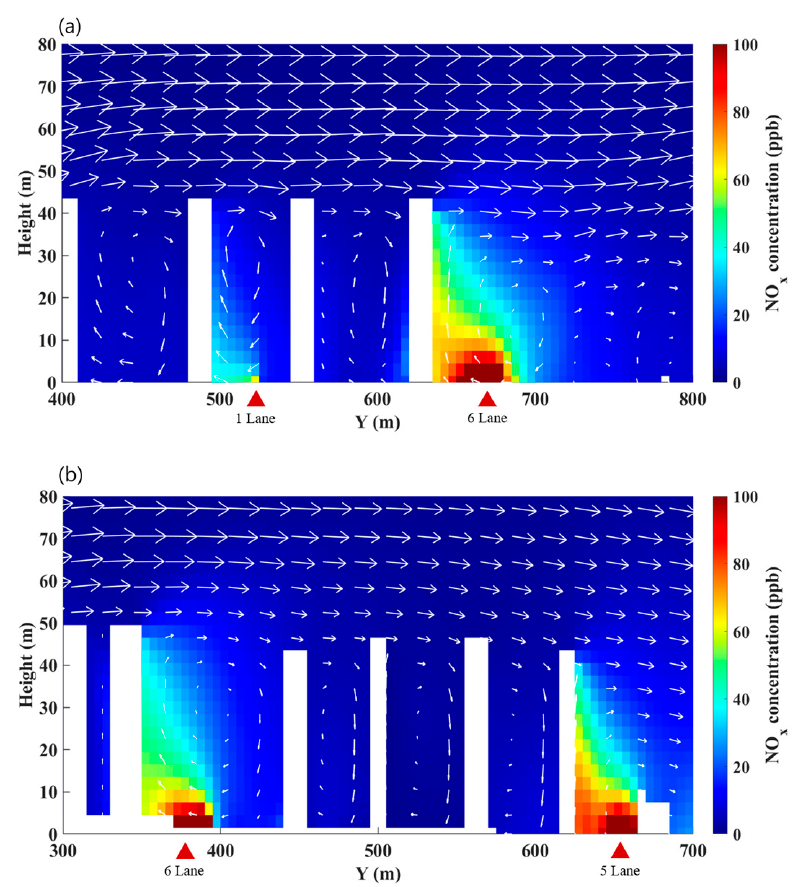
Figure 6. The y - z vertical cross-sections of simulated NO x concentration fields at ( a ) x = 207 m and ( b ) x = 705 m. The arrows indicate the wind vectors of v and w components.